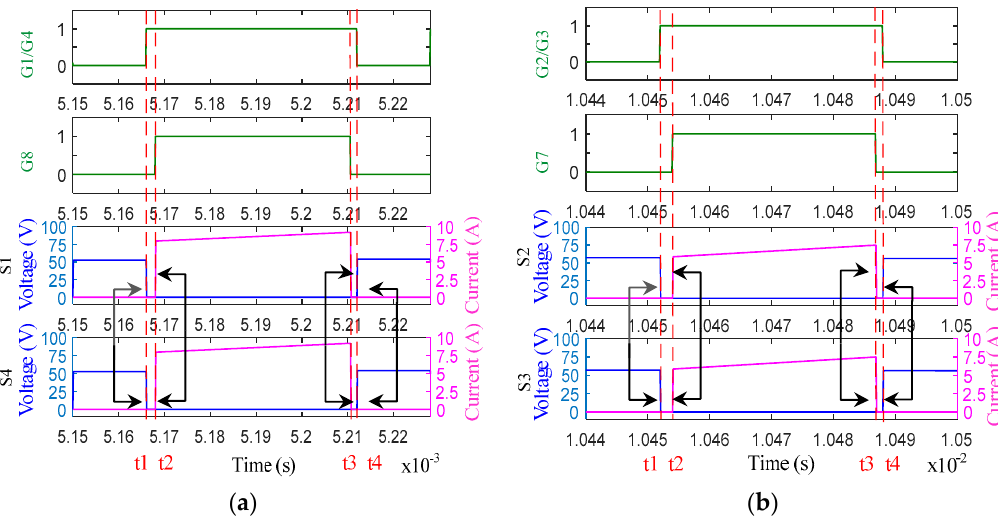
Figure 15. Simulation results of the improved HERIC inverter ( a ) The positive cycle; ( b ) The negative